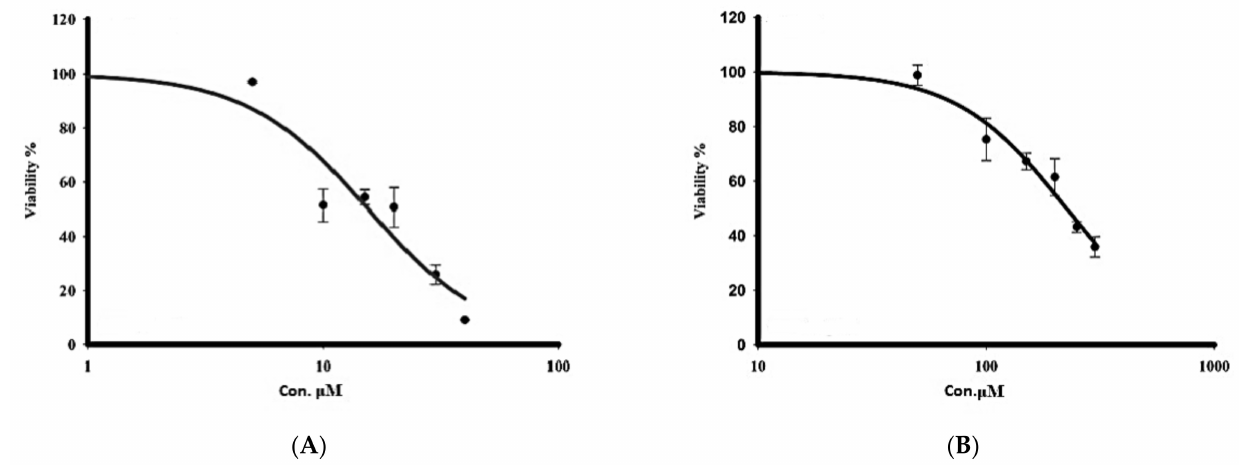
Figure 4. Effect of treatment with sorafenib ( A ) and crocin ( B ) on HepG2 cell viability. IC50 value corresponds to the concentration leading to a loss of 50% of cell viability. Data were expressed as mean ± SEM for three replicates ( n =